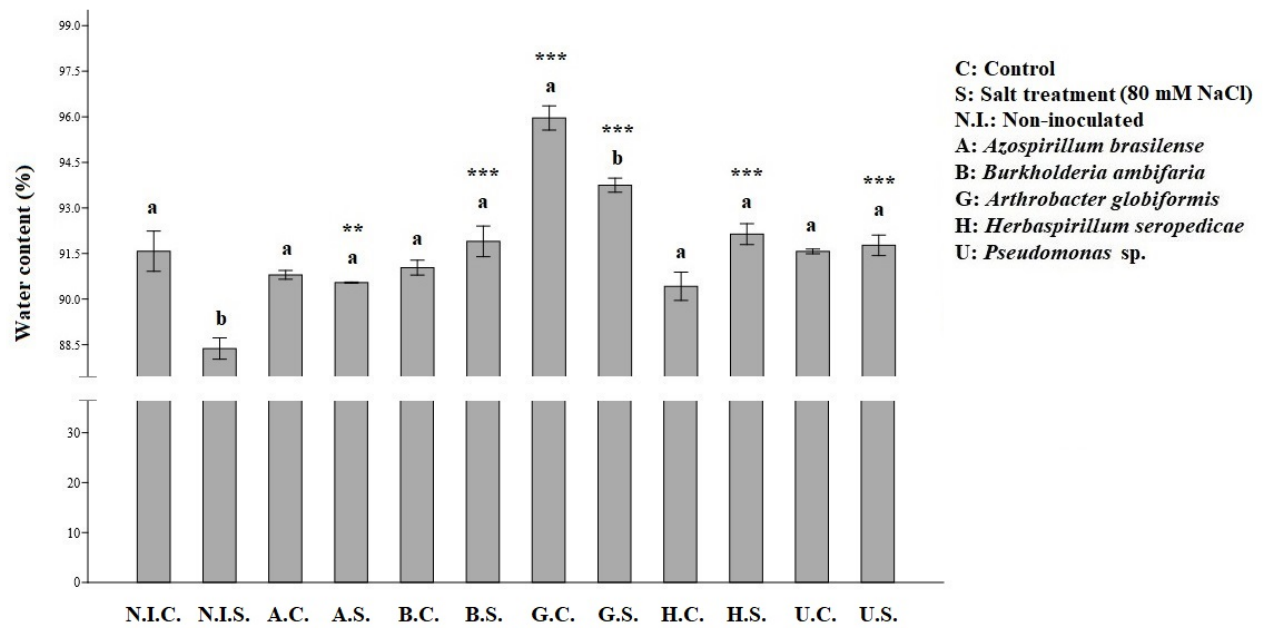
Figure 2. Water content of the plants in non-saline (C) and in saline soils (S). Data are expressed as means ± SE ( n = 8). N.I. = non-inoculated. Mean values in the column marked by different letters are significantly different within the same group ( p ≤ 0.05; ANOVA and Tukey–Kramer test). Significant differences between groups are reported as ** p < 0.01; *** p < 0.001. Table 2. Proline and phenolic compounds of B. napus cv. SY Saveo grown for 30 days on non- saline soil (C) or saline soil (S). Plants were inoculated with plant growth-promoting bacteria (A = A brasilense , B = B ambifaria , G = A globiformis , H = H seropedicae , U = Pseudomonas sp. UW4) or not (N.I. = non-inoculated). Different letter means significant difference within the same bacterial treatment. Significant differences between inoculated or not inoculated plants grown at the same soil conditions are marked as * ( p < 0.05), *** ( p < 0.001) ( n = 9). Proline (nmoles/mg